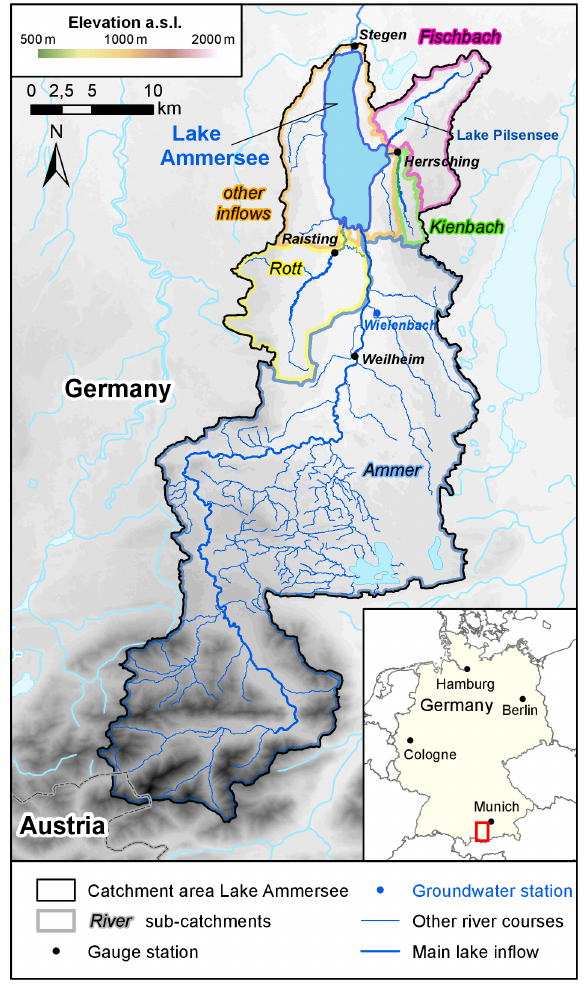
Figure 7. Catchment area (with subcatchments) of lake Am- mersee. Dots mark the locations of hydrological observation sta- tions (Source DEM: elevation data from ASTER GDEM, a product of METI and NASA; Source geodata: Geobasisdaten © Bayerische Vermessungsverwaltung, http://www.geodaten.bayern.de, last ac-